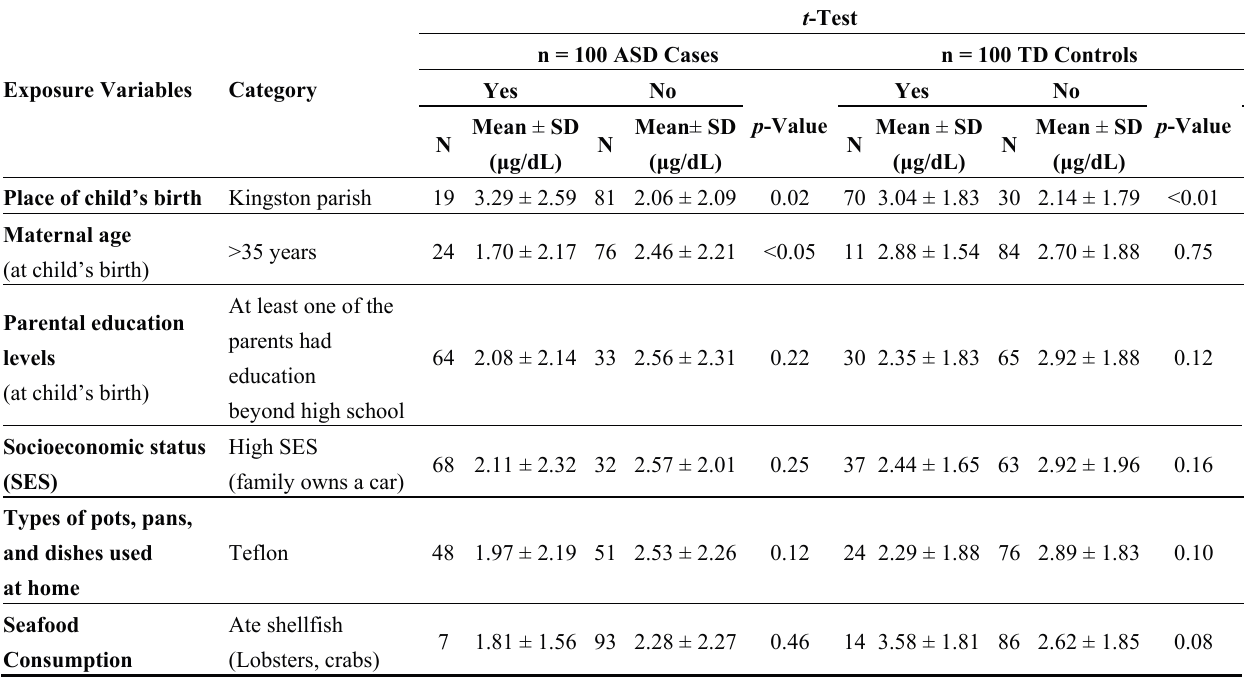
Table 5. Associations between individual covariates in the final multivariable GLM